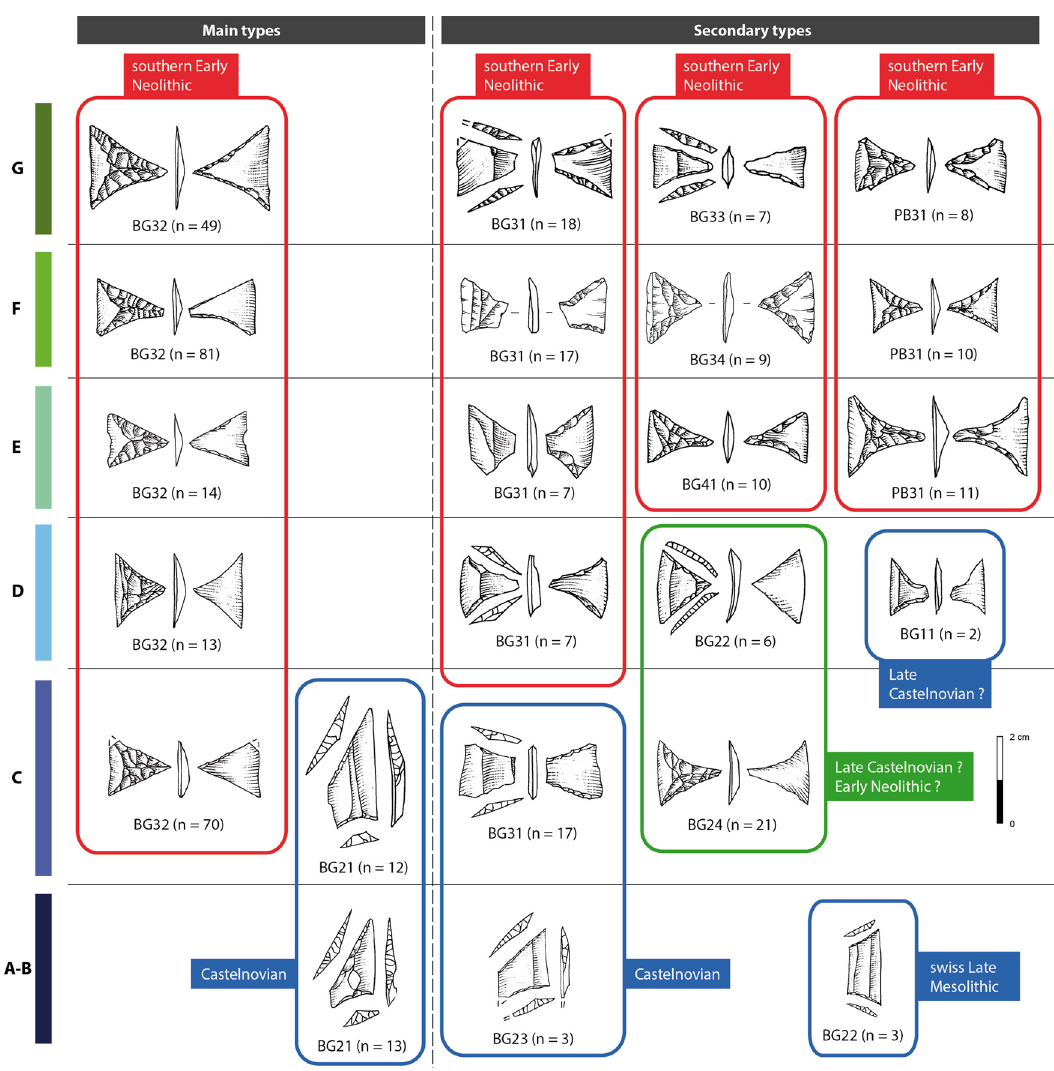
Figure 12: Proposed interpretation of the lithic arrowhead typologies of the di ff erent archaeological sets. Drawings: R. Picavet and J. - B. Lajoux. CAD: M. - A.